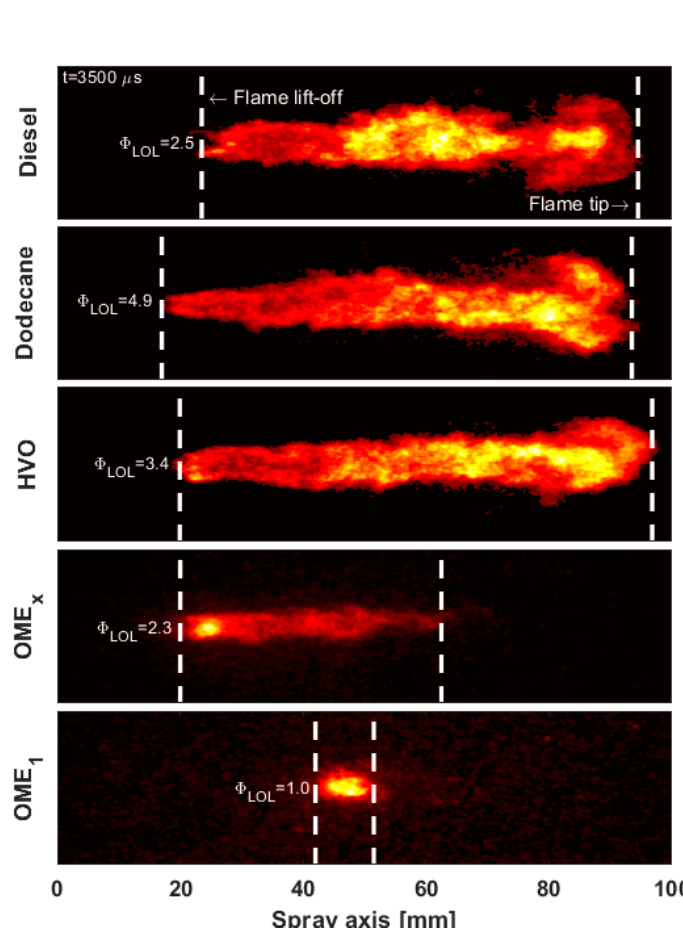
Figure 10. Flame images from OH* chemiluminescence for all fuels at the nominal operating condition at 3500 µs ASOI.